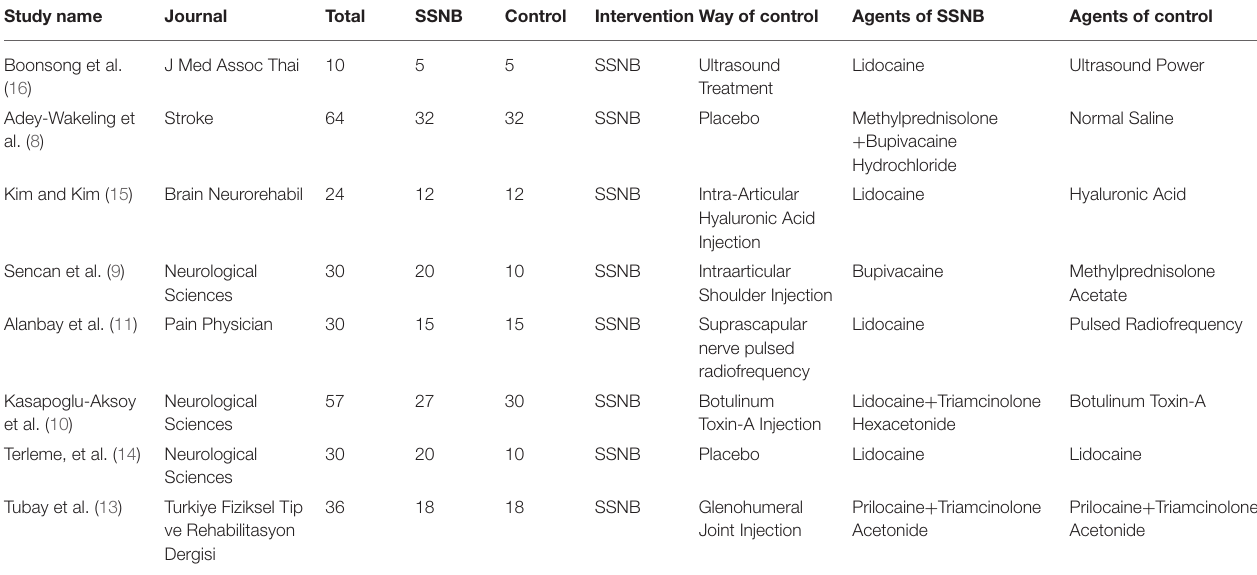
TABLE 1 | Baseline characteristics of included